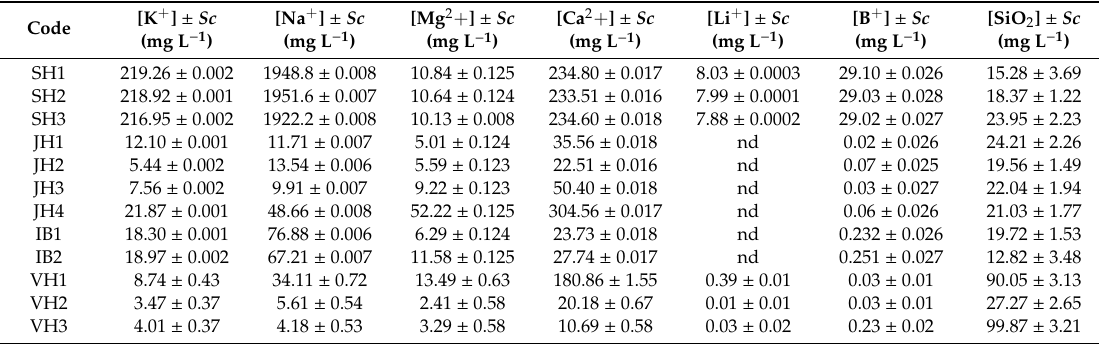
Table 5. Cation concentration of the geothermal manifestation in Seulawah Agam mountain.